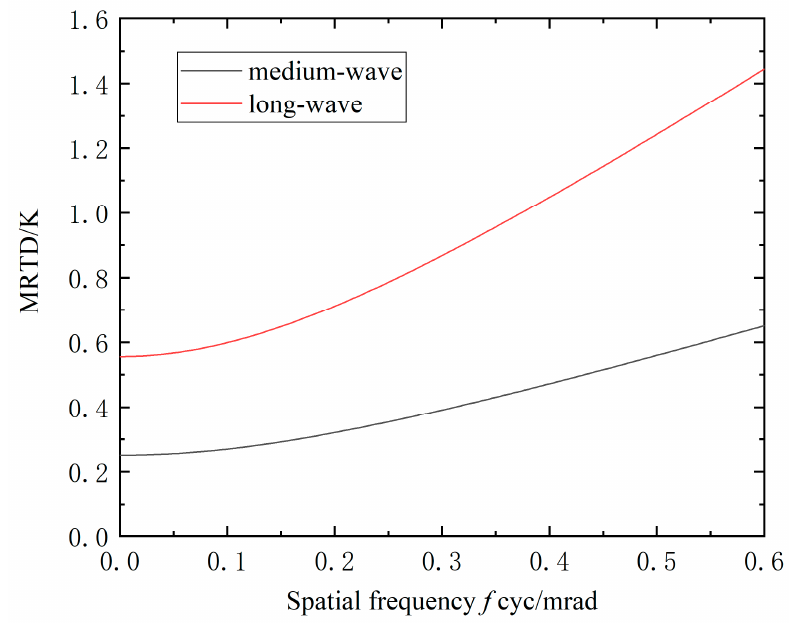
To further analyze the difference in temperature resolution of IPD in different bands, a simulation experiment of MRTD with background temperature T B was completed (as shown in Figure 8).